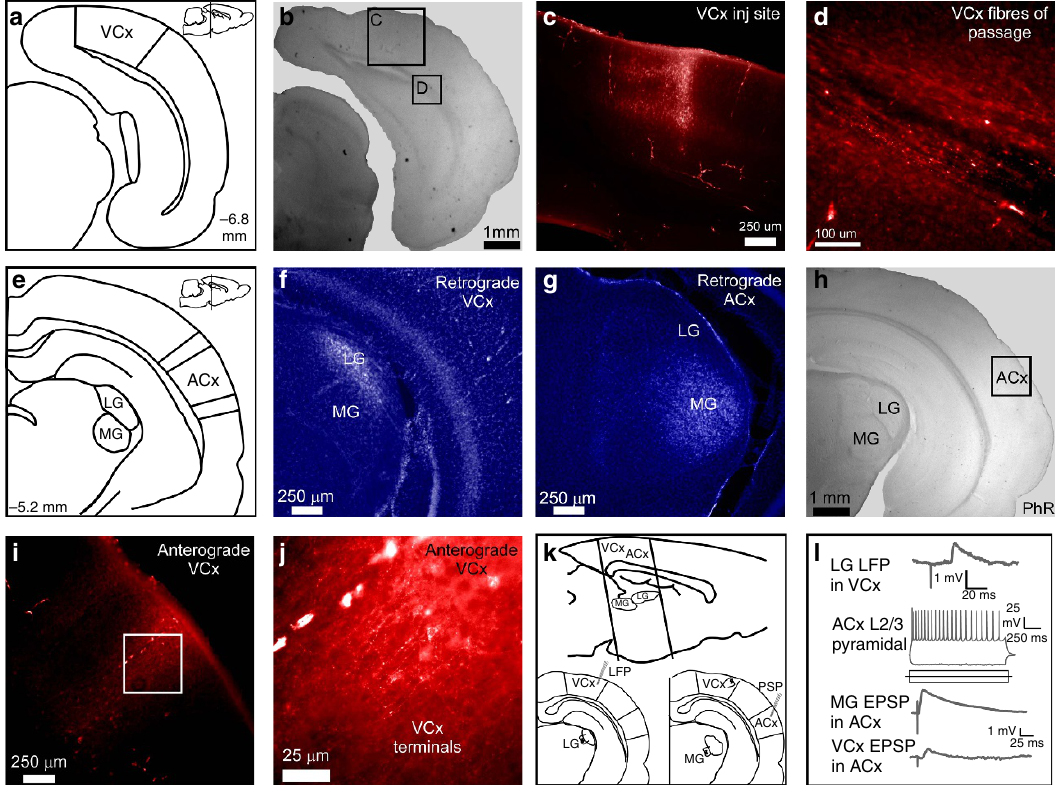
Figure 6 | Direct functional projection from VCx to ACx. ( a ) Diagram shows the stereological location of VCx in the coronal plane and sagittal